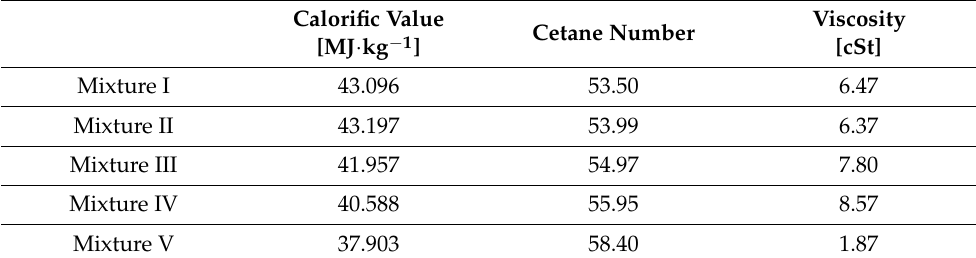
Table 4. Mean quantities of energetic value, cetane number and